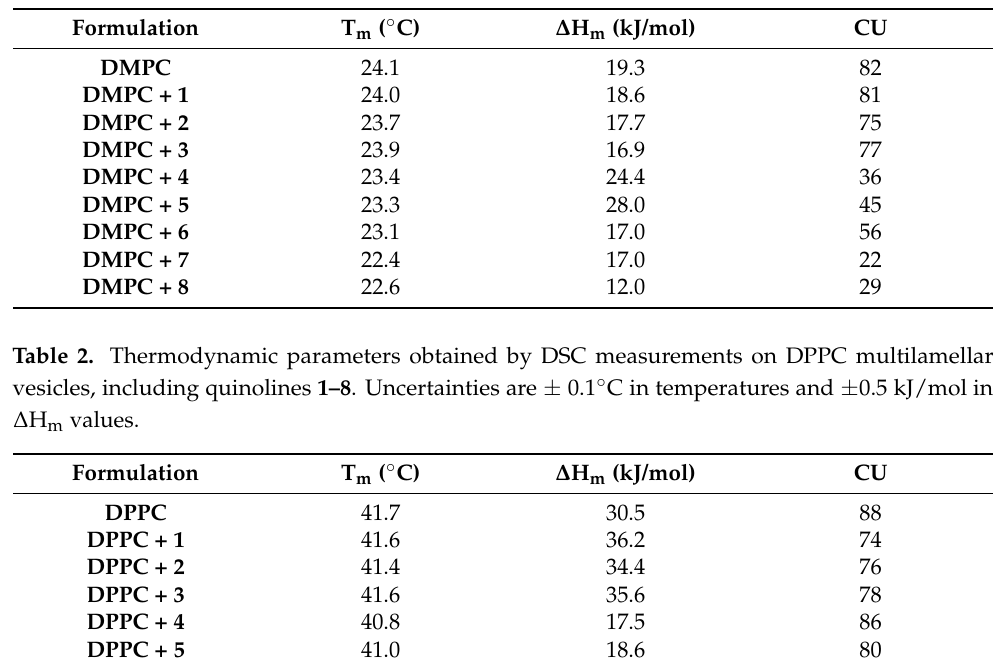
Table 1. Thermodynamic parameters obtained by DSC measurements on DMPC multilamellar vesicles with included quinolines 1–8 . Uncertainties are ± 0.1 ◦ C in the temperatures and ± 0.5 kJ/mol in the ∆ H m values.